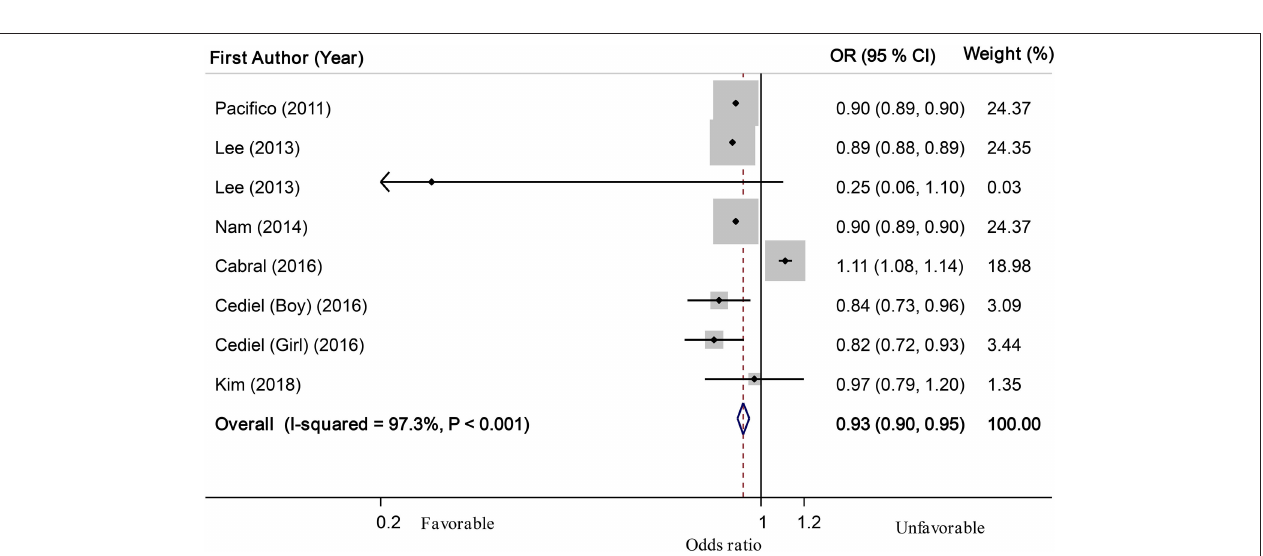
elevated from 20 to 40 ng/mL, there was a steeper drop in the odds of abdominal